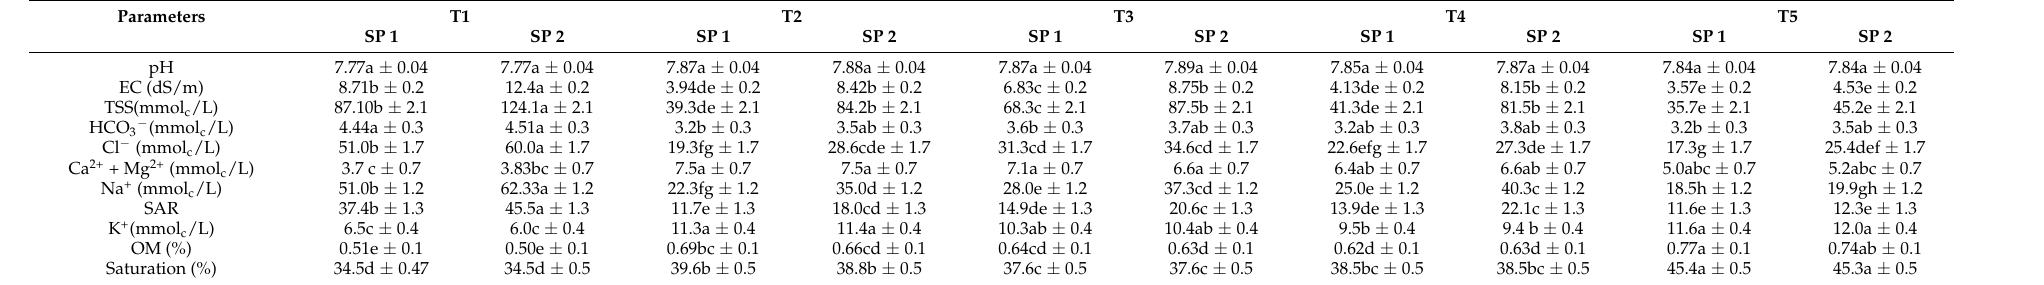
Table 1. Effect of various organic amendments and agroforestry trees species on post-harvest soil characteristics.